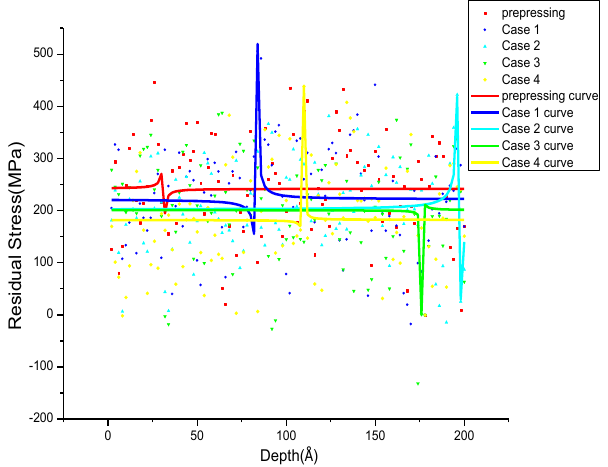
Figure 9. σ yrs distribution after annealing with different annealing parameters.